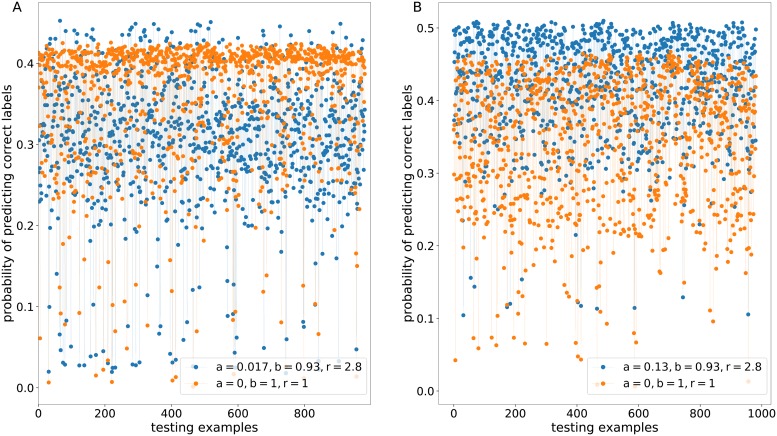
The probabilities of predicting correct labels in the presence of adversarial perturbations for the advanced sigmoid activation function with the hyperparameters aopt, bopt, ropt and the simple sigmoid activation function with the hyperparameters a = 0, b = 1, r = 1.(A) The hyperparameters are equal to aopt = 0.017, bopt = 0.93, ropt = 2.8. (B) The hyperparameters are equal to athreshold = 0.13, bopt = 0.93, ropt = 2.8.